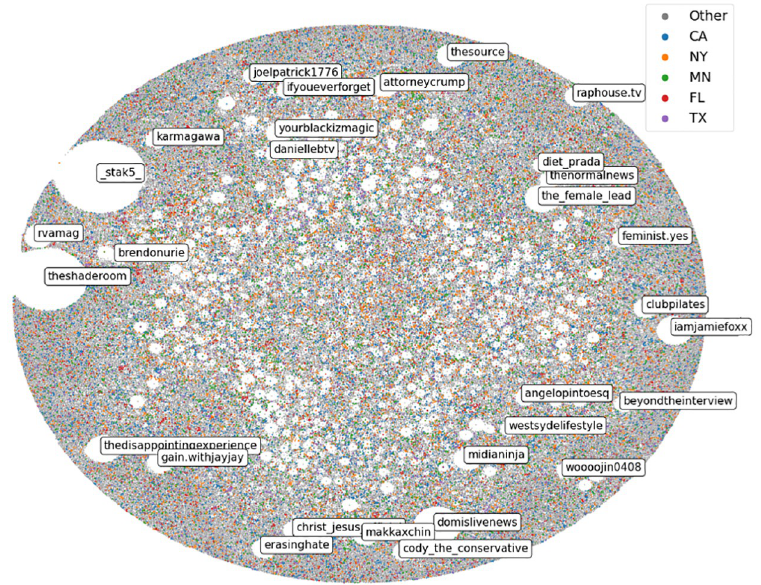
Fig 5. Network of users (n = 713,209), where links are constructed between commenting users and the original poster. Small, dense communities in the center indicate diverse consumption of content.